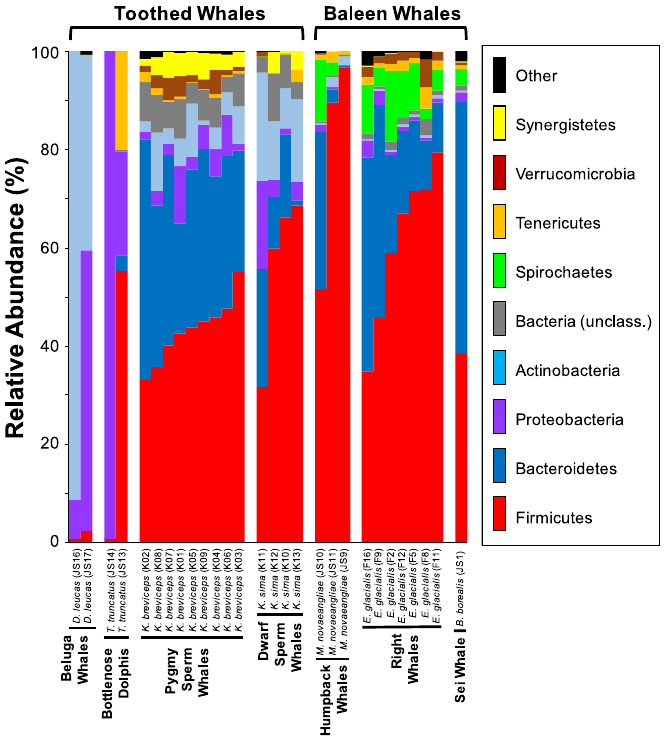
Figure 1. Phylum-level composition of gut microbiomes in Kogia breviceps and K . sima compared with previous data from other toothed and baleen whales 25 . Relative abundances of common microbial phyla are shown in color, with rare phyla (other) in black (Fusobacteria, Euryarchaeota, Lentisphaerae, Cyanobacteria, Planctomycetes, Fibrobacteres, Deferribacteres, TM7, TM6, Acidobacteria, Elusimicrobia, Armatimonadetes, Thermi, and